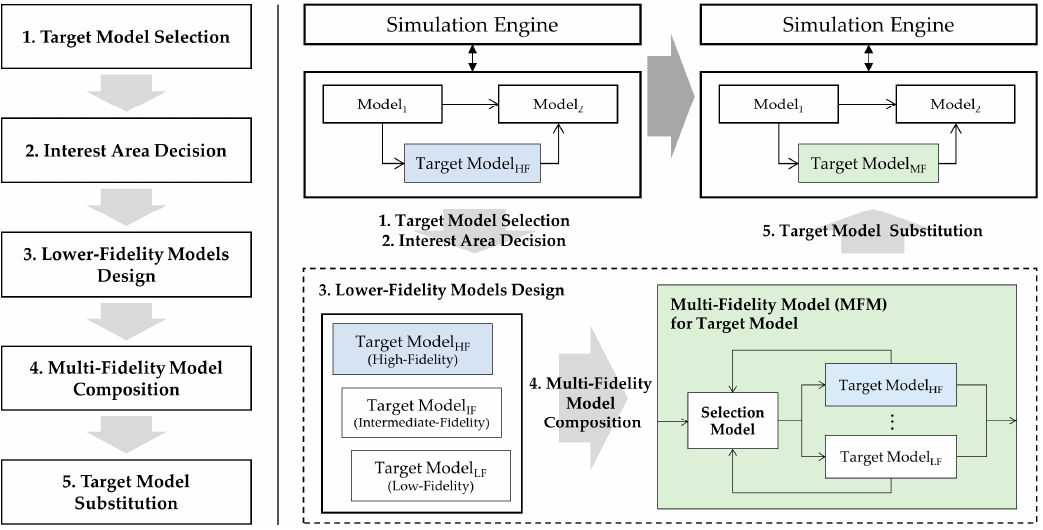
Figure 5. Proposed multi-fidelity modeling framework.